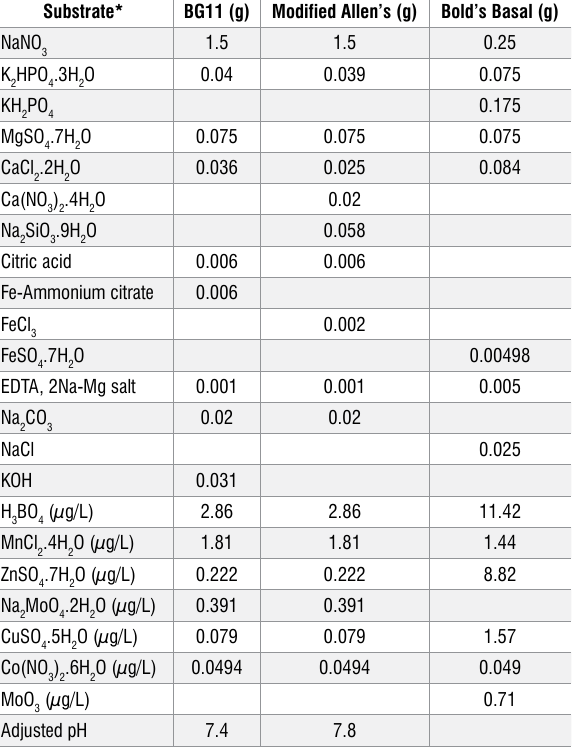
Table 4: Recipe of some selected growth medium for different algae Substrate*